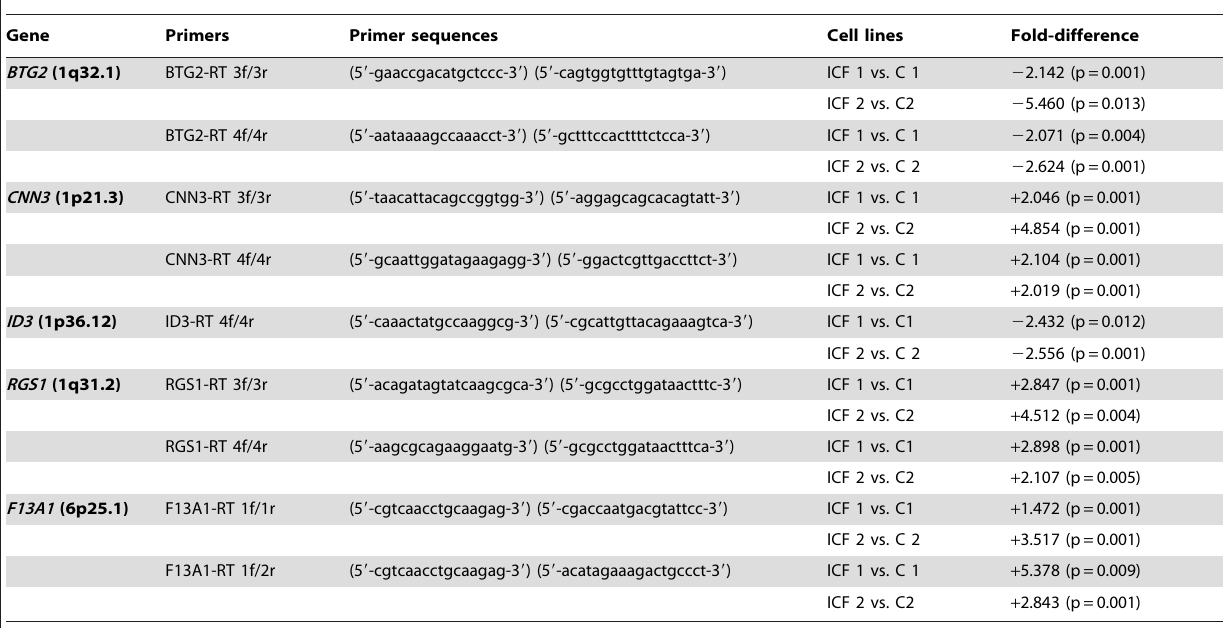
Table 4. Gene expression analysis by real-time